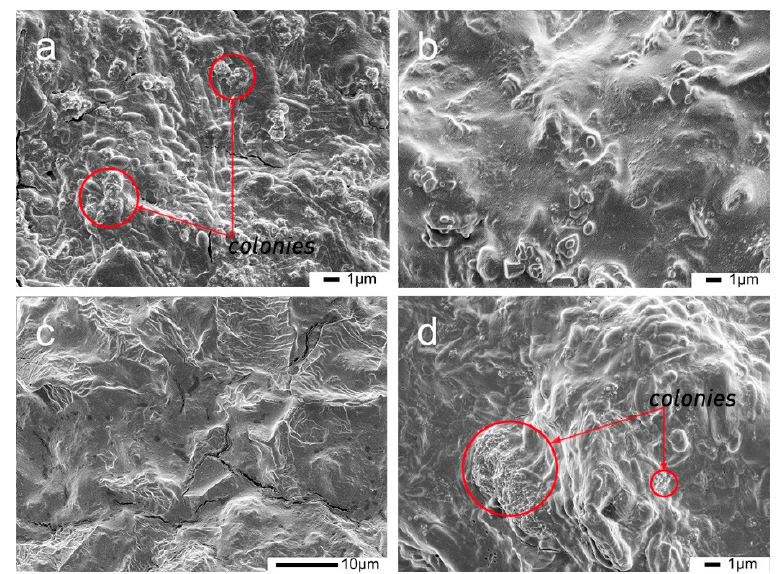
Figure 2. SEM of the different soy meal (SM) samples after 15 days of cultivation at 28 °C and 95% RH: ( a ) (SM/5% preservative A), ( b ) (SM/5% preservative B), ( c ) (SM/5% preservative C), and ( d ) (SM).